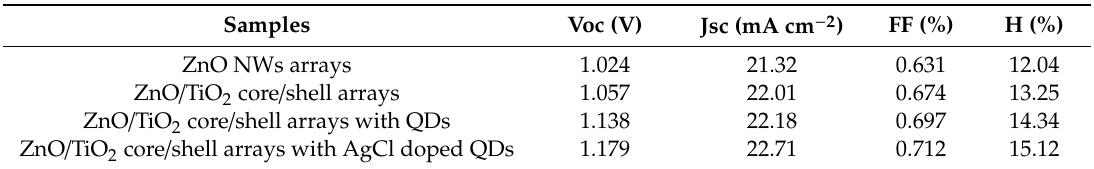
Table 1. Photovoltaic parameters of PSCs based on ZnO / TiO 2 core / shell arrays with AgCl-doped CdSe quantum dots under 100 mW / cm 2 of AM 1.5